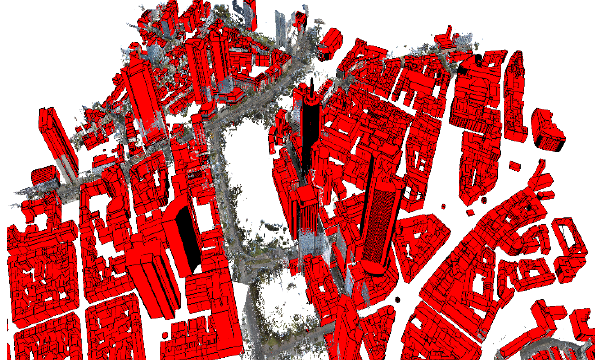
Figure 1. GUI showing CityGML LOD2 overlaid with Mobile Mapping point cloud Users have the possibility to select façades of interest for the reconstruction process. Prior to the reconstruction, points belonging to the selected façade have to be extracted from the point cloud. For that purpose all points have to be transformed into a local coordinate system defined by the selected façade. Only points within a clip box around the façade are stored for further processing. Figure 3 shows exemplarily a selected façade (depicted in green) with the corresponding local coordinate system. The underlying building model consists of LOD2.